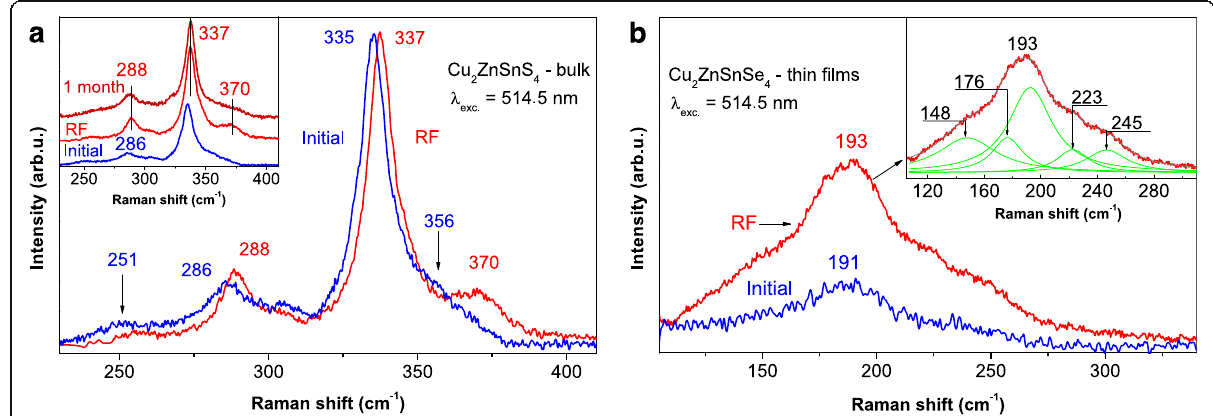
Fig. 5 Raman spectra of bulk samples before ( blue curves ) and after ( red curves ) RF treatment for materials. a CZTS ( inset shows the spectra before, straight after, and 1 month after RF treatment). b CZTSe film deposited onto Cu/Mo coated glass ( inset shows the deconvolution by Lorentzian